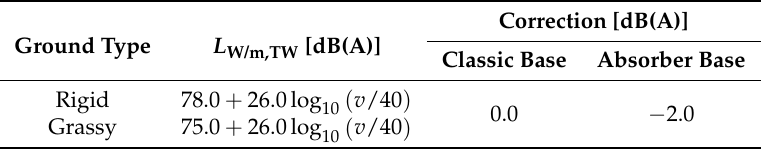
Table 5. Emission powers per metre of lane for tramways (TW) according to the ground type with the corrections associated with the nature of the rail